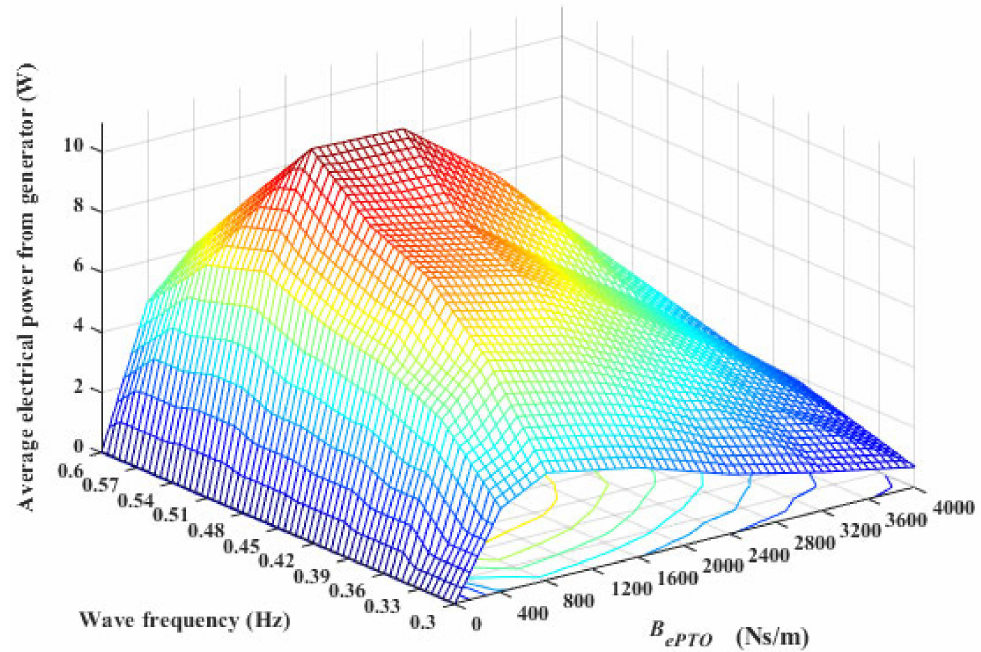
Figure 17. Power output from the electrical machine for a range of wave frequencies with the generator controlled to give a variable damping stiffness ( B ePTO ). Wave height H = 0.2 m, f = 0.3 to 0.6